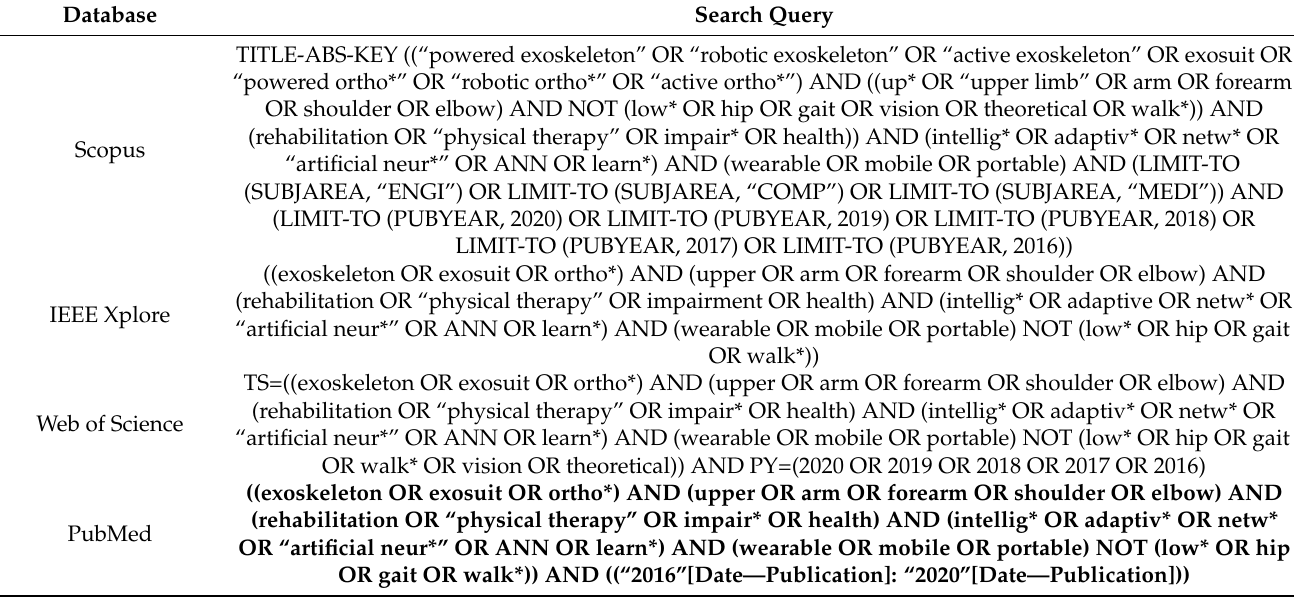
Table 1. Explicit formulation of the search queries for each database. Database Search Query